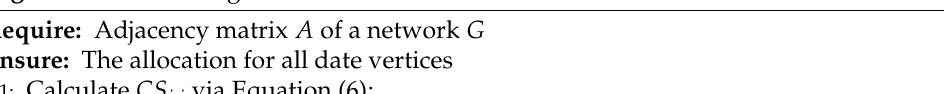
Algorithm 1 EDPC